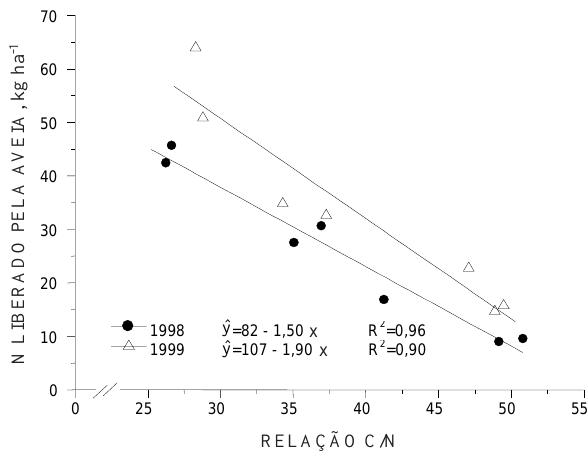
Figura 3. Influência da relação C/N da fitomassa da aveia sobre a quantidade de N liberado aos 110 dias (1998) e aos 125 dias (1999) do manejo dos